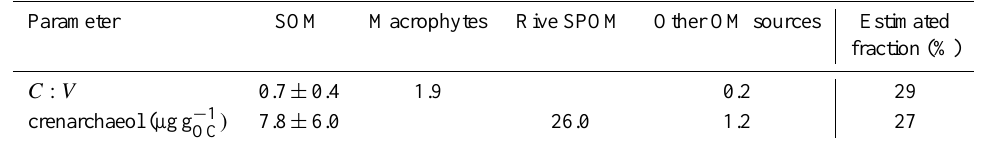
Table 6. Data used in Eqs. (1) and (2) to estimate the fraction of OM derived from macrophytes and aquatic OM to the SOM. Parameter SOM Macrophytes Rive SPOM Other OM sources Estimated